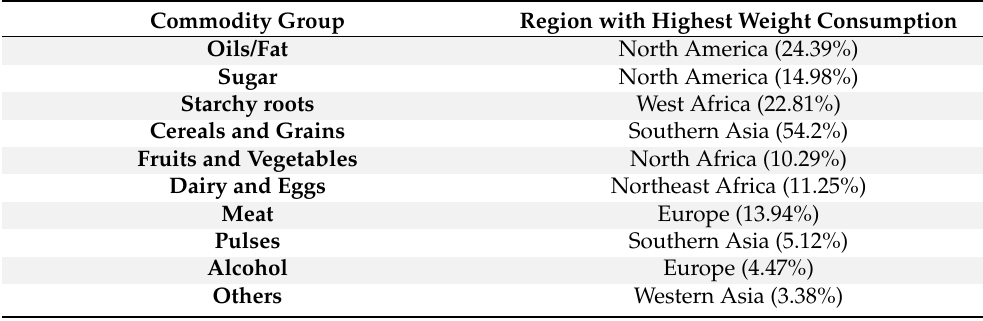
Table 2. Regions with the highest weighted consumption of the 10 total commodity food groups.